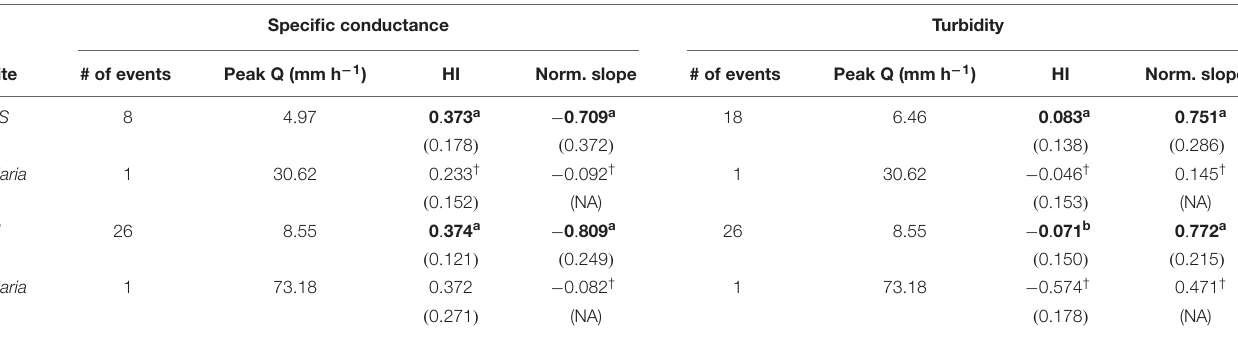
TABLE 2 | Summary statistics of storm events across Quebrada Sonadora (QS) and Rio Icacos (RI) and during Hurricane Maria. Specific